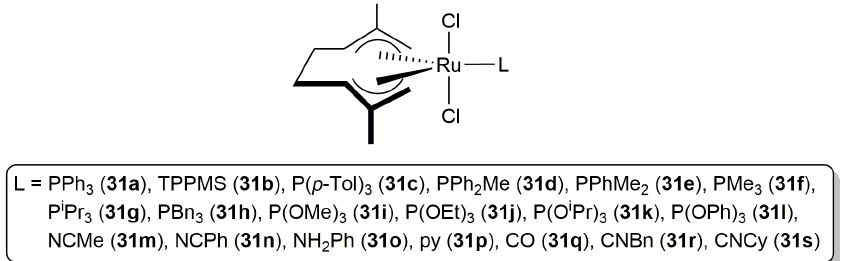
Figure 6. Structure of the bis(allyl)-ruthenium(IV) complexes 31a–s .